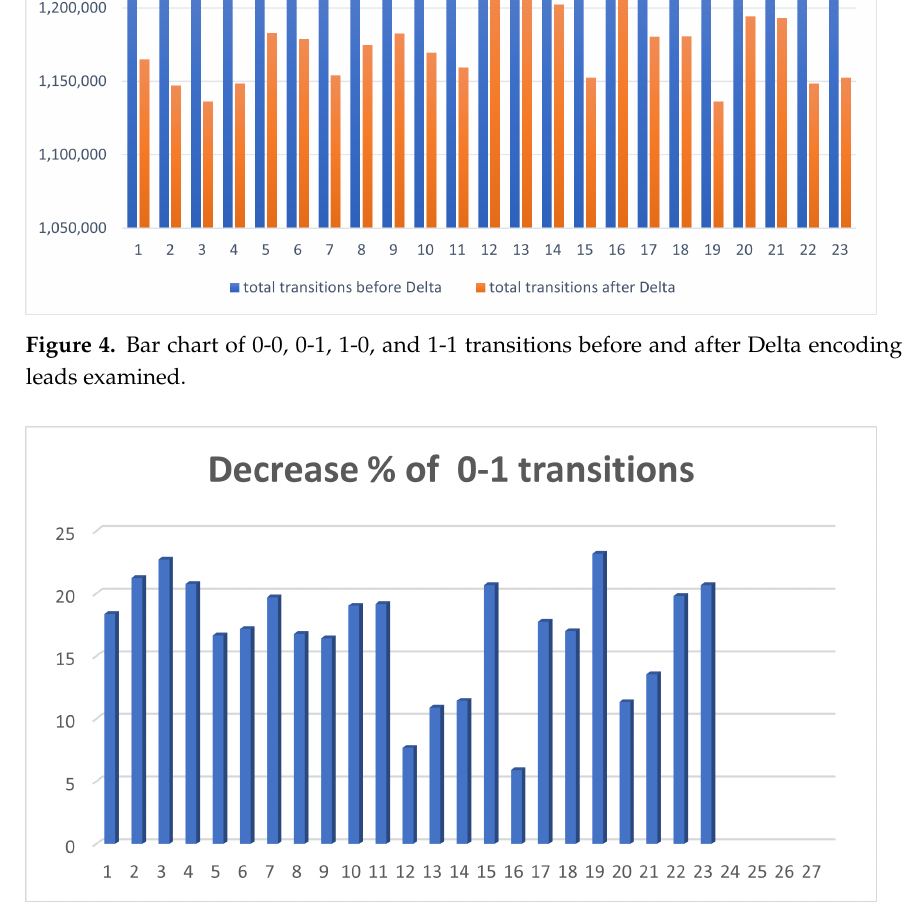
Figure 5. Bar chart of % reduction of 0-1 transitions after the encoding.